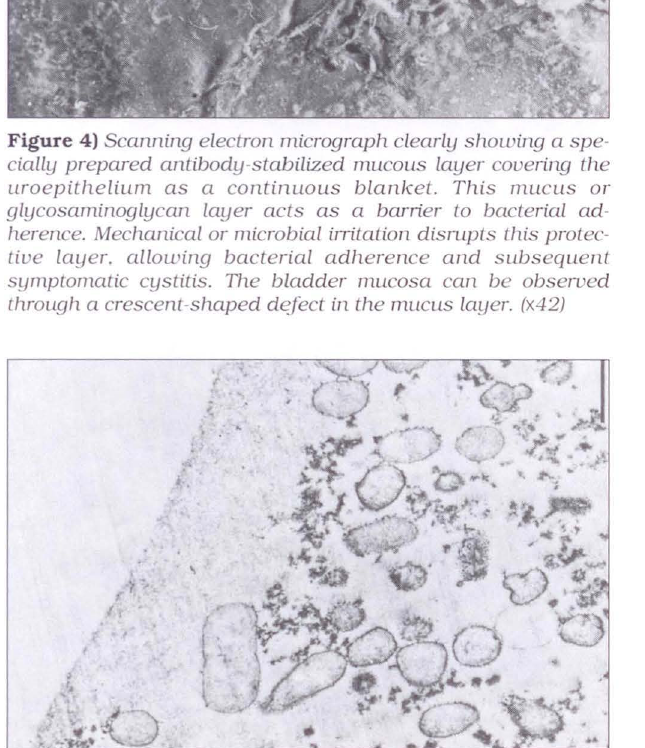
Figure 5) Transmission electron micrograph q_{ a mthenium red-stained antibody-stabilized preparation of the luminal sur face of a pseudomonas biofilm. Antibody stabilization of the surface demonstrates the fibrous anionic matrix binding the bacterial cell.s together into the biofilm. Through a number of mechanisms this matrix protects the bacte1ia within the biq_/).lm from antibiotics. even though individual bacteria remain suscep tible. Bar 1 >LTTI. (Reproduced with permission from reference 28) U1ese planktonic floa ting cells in U1e urine, and